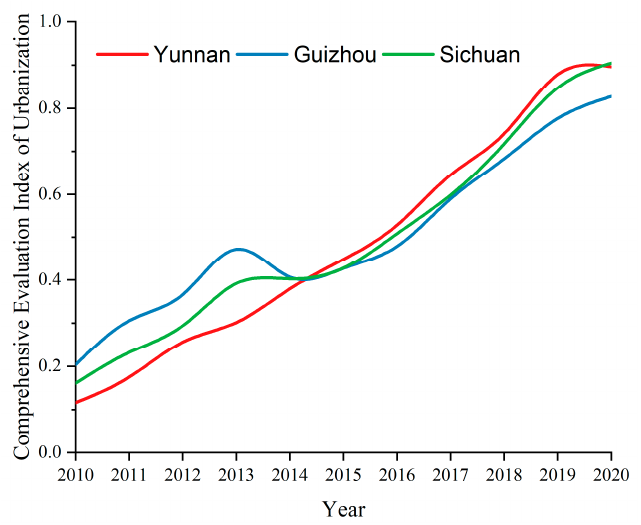
Figure 5. Temporal changes of the urbanization development level.